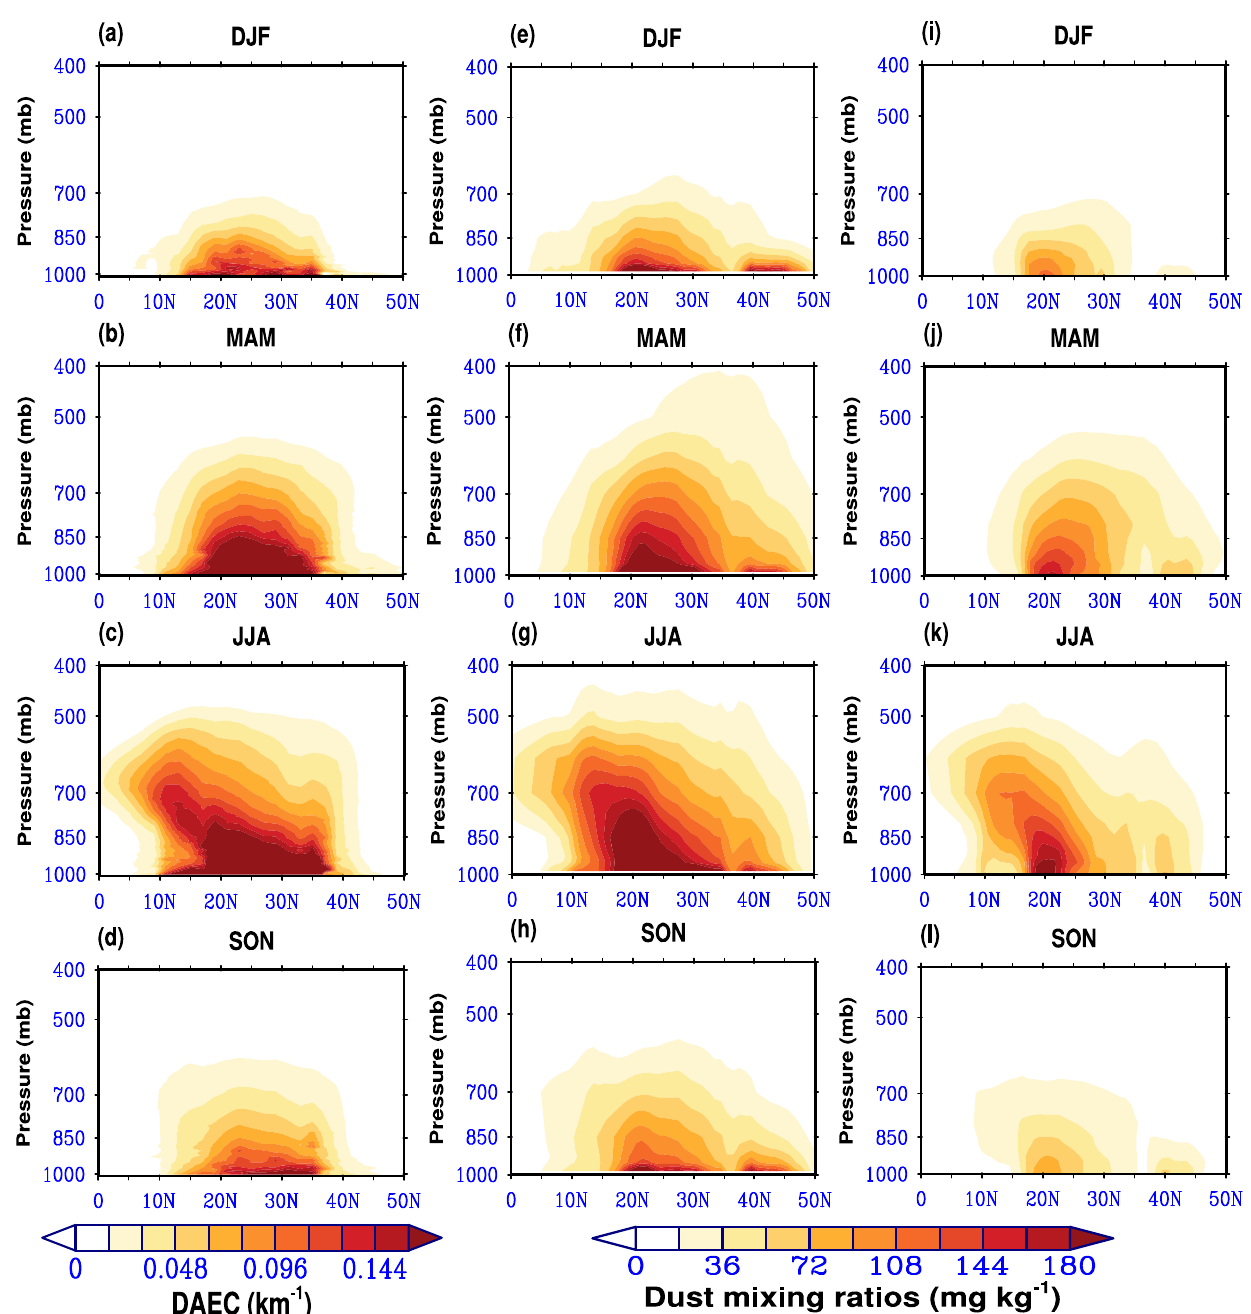
Fig. 4 Zonal climatology of dust aerosol distribution over Arabian Peninsula. Seasonal zonal climatology of Dust aerosol extinction from CALIOP ( a – d ), and dust mixing ratios from MERRA-2 ( e – h ) and CAMS ( i – l ) over the Arabian Peninsula (zonally averaged between 43°E and 60° E) during the period 2007 – during winter (Fig. 5a), whereas uplifting of the dust to the higher the dust aerosols over the AP, MERRA-2 captures the summer levels is observed in spring and summer (Fig. 5b, c). Over the AS, meridional dust features and slantwise dust advection more summer is the most active “ dust ” season, with a core (DAEC > effectively than CAMS. 0.16 km − 1 ) between 20 and 30°N. Furthermore, the low-level Geographically, the AS is bordered by hotspots of dust, which result in a high dust accumulation in this region. The immediate northerly winds from Iran 52,53 and the north westerlies from AP 30 dust sources in the northern AS are topographically elevated further contribute to the higher DAEC values observed between (>1000 m) than those in the westside (<250 m). Figure 5 presents 20 and 25°N. Tandule et al. 54 identi fi ed the maximum dust activity the seasonal characteristics of the meridional dust distribution over the AS during summer using the CALIOP observations. over AS. As shown, AS is covered by dust throughout the year, Similar to the AP, an advection of dust from the north favors the although its intensity is characterized by strong seasonality. The formation of an uplifted dust layer above the 850 hPa level dust is con fi ned to the lower levels of the atmosphere (<1 km) between 10 and 20°N. The dust activity over the AS weakens